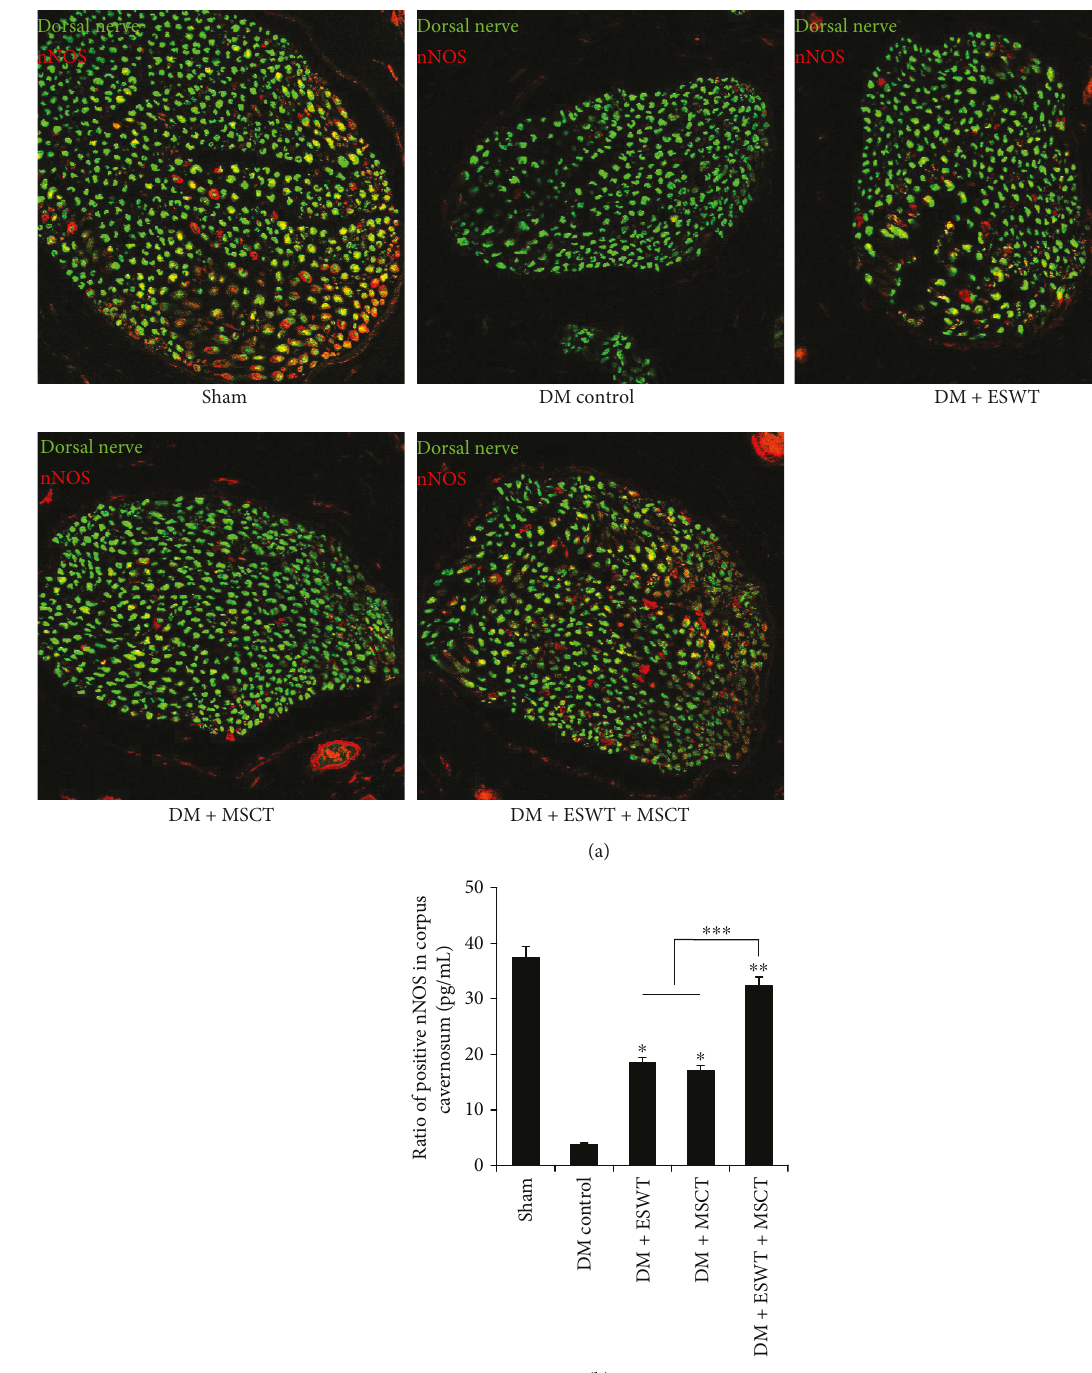
Figure 6: ESWT+MSCT induce nNOS expression in the corpus cavernosum. (a) Representative images of nNOS staining in the corpus cavernosum. (b) Ratio of positive nNOS of each group. Each bar shows the mean values (standard deviation). Original magni fi cation: × 400. ∗ P < 0 05 compared with the DM control group. ∗∗ P < 0 01 compared with the DM control group. ∗∗∗ P < 0 05 compared with the DM+ ESWT and DM +MSCT